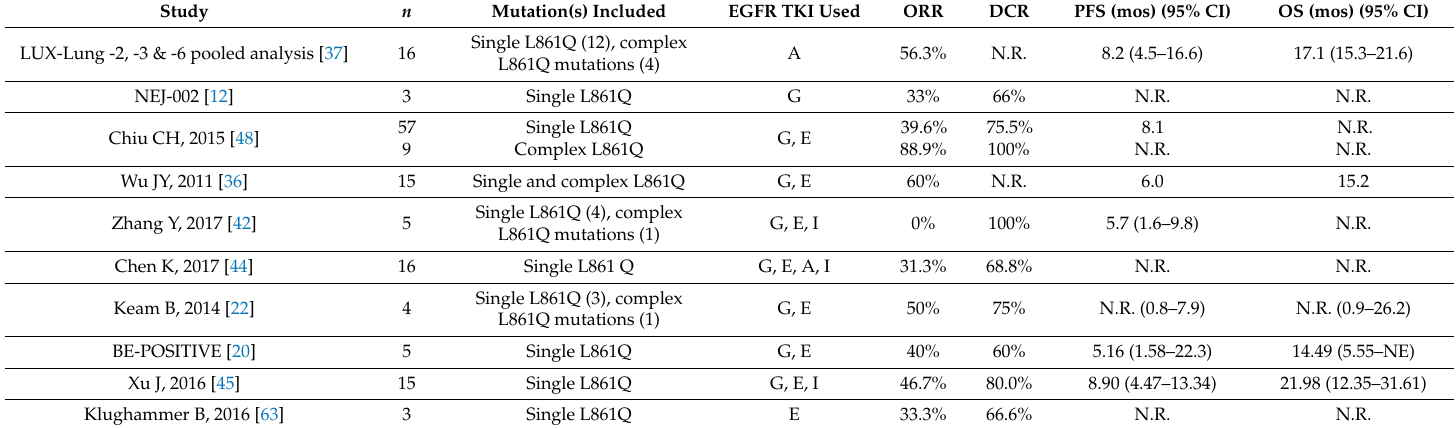
Table 4. Activity of first-/second-generation EGFR in patients harboring L861Q single and compound